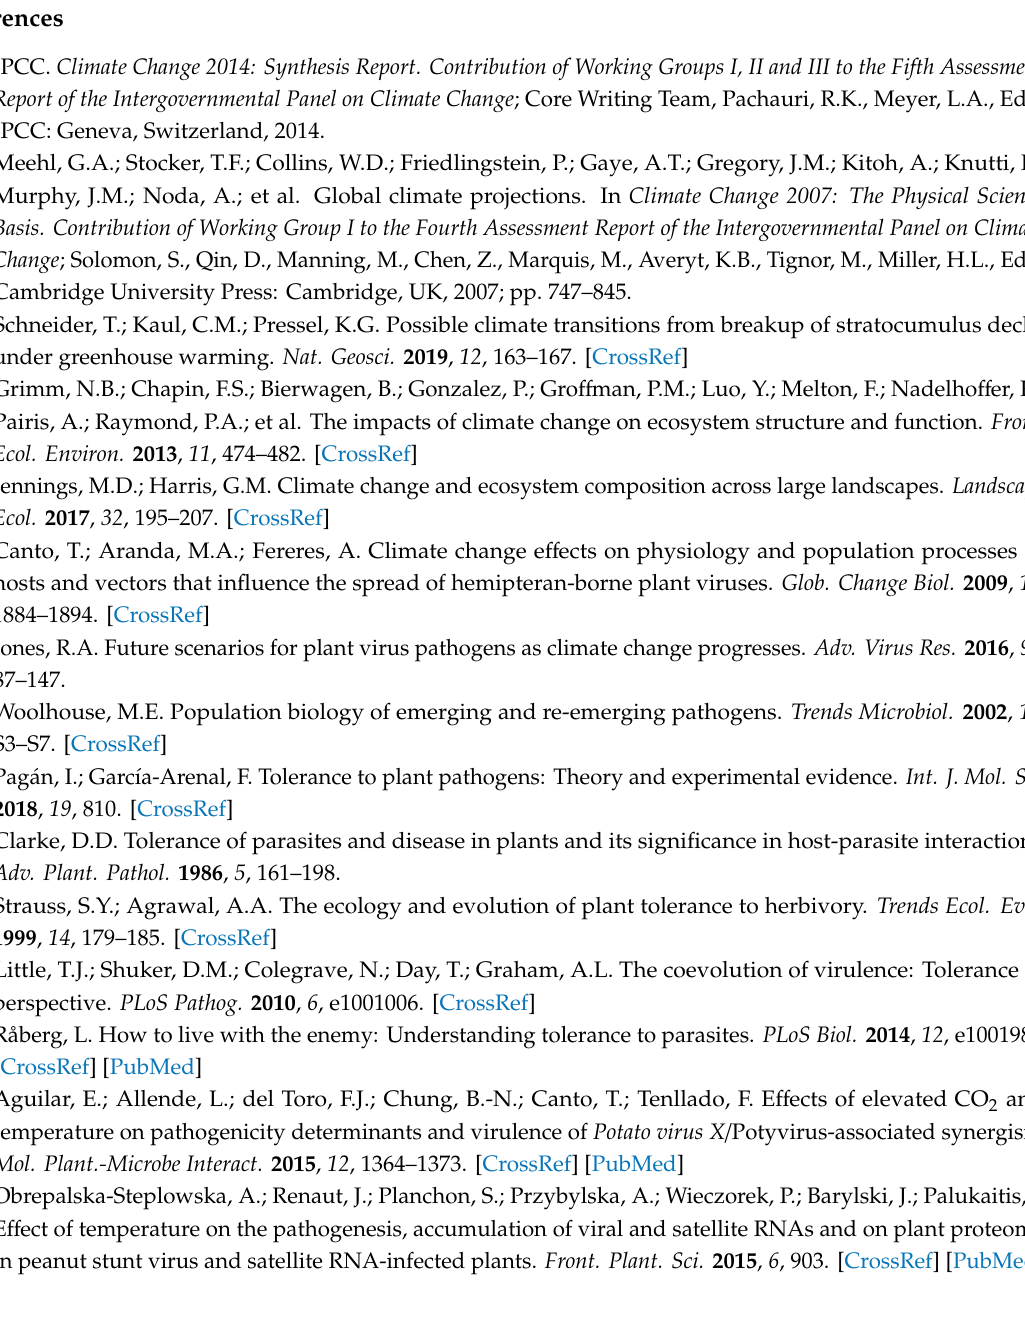
Table S1: TuMV and CMV infection parameters measured in the 18 Arabidopsis accessions, Table S2: Results of Principal Component Analyses for the performance of Arabidopsis upon virus infection at di ff erent light